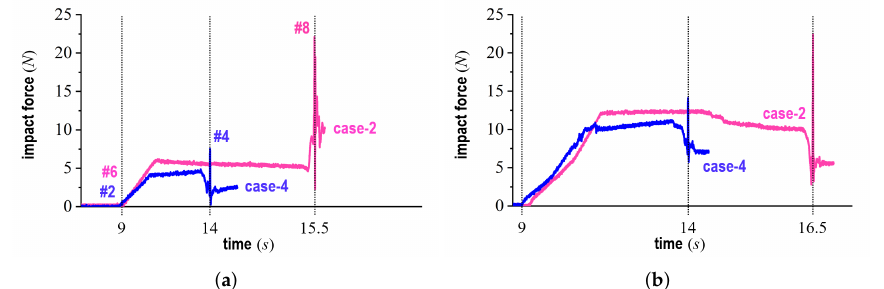
Figure 20. Comparison results for impact forces generated when climbing steps where case-2 and case-4 denote the wheel with a vertically translated axle and the proposed wheel, respectively. More- over, the frame numbers under the case of 20 mm mean a specific motion scene in Figures 16 and 17a, respectively. ( a ) Step height of 20 mm, ( b ) step height of 30